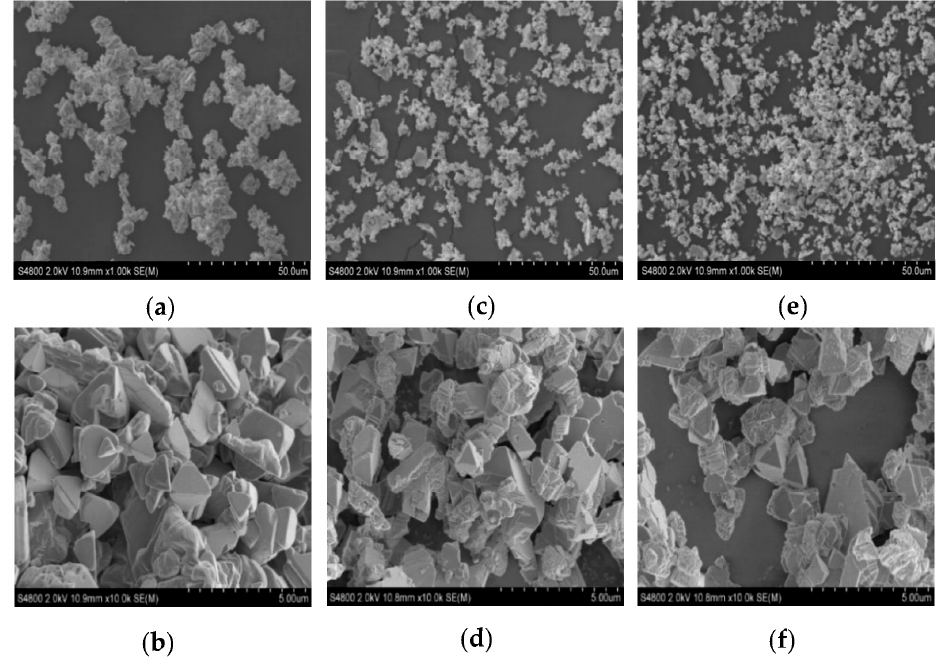
Figure 3. SEM images of CuI NPs with magnifications of ( a ) 1000× (CuI), ( b ) 10,000× (CuI), ( c ) 1000× (2.5 GA-CuI), ( d ) 10,000× (2.5 GA-CuI), ( e ) 1000× (5.0 GA-CuI) and ( f ) 10,000× (5.0 GA-CuI).